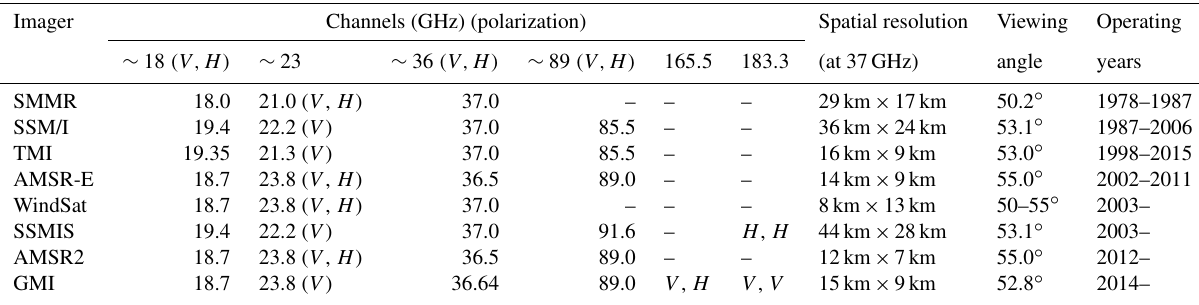
Table 1. Characteristics of the MW imagers over the years. Imager